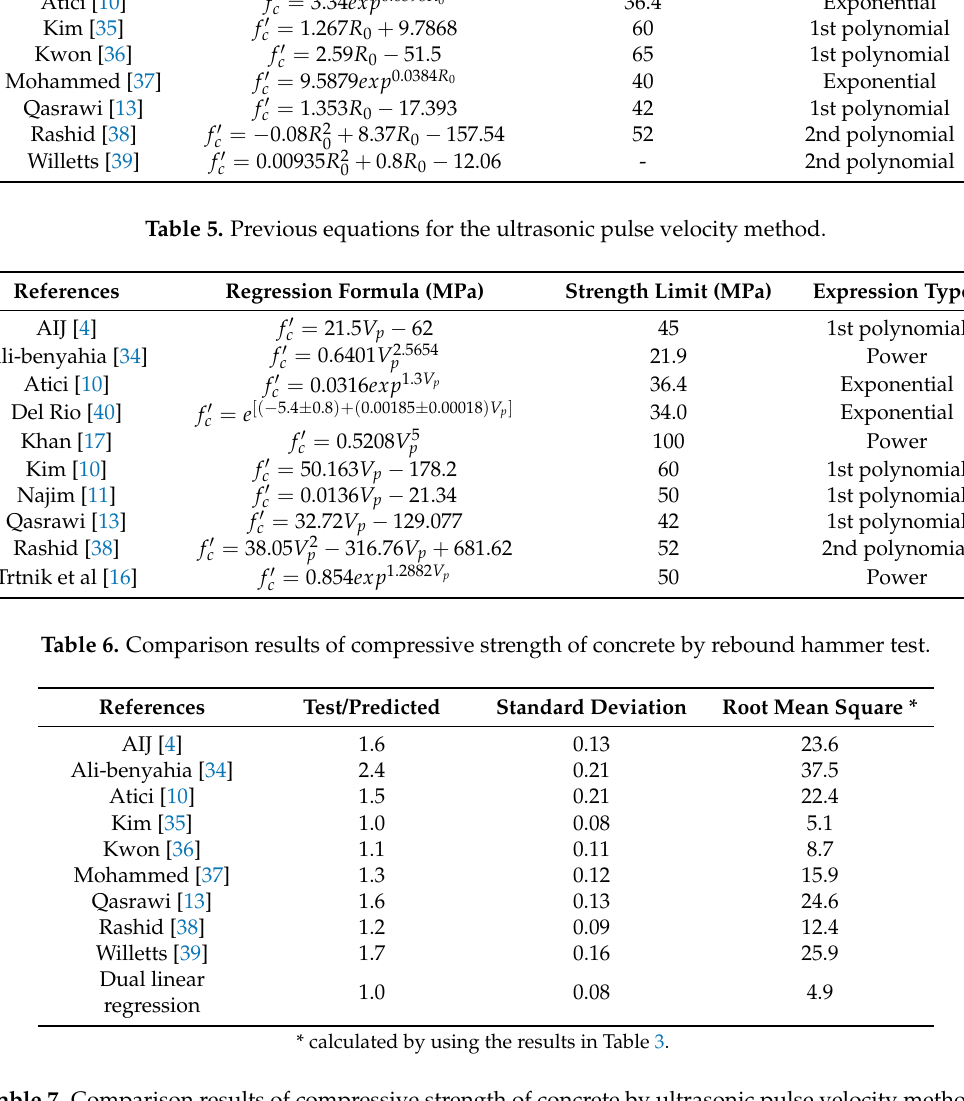
Table 7. Comparison results of compressive strength of concrete by ultrasonic pulse velocity